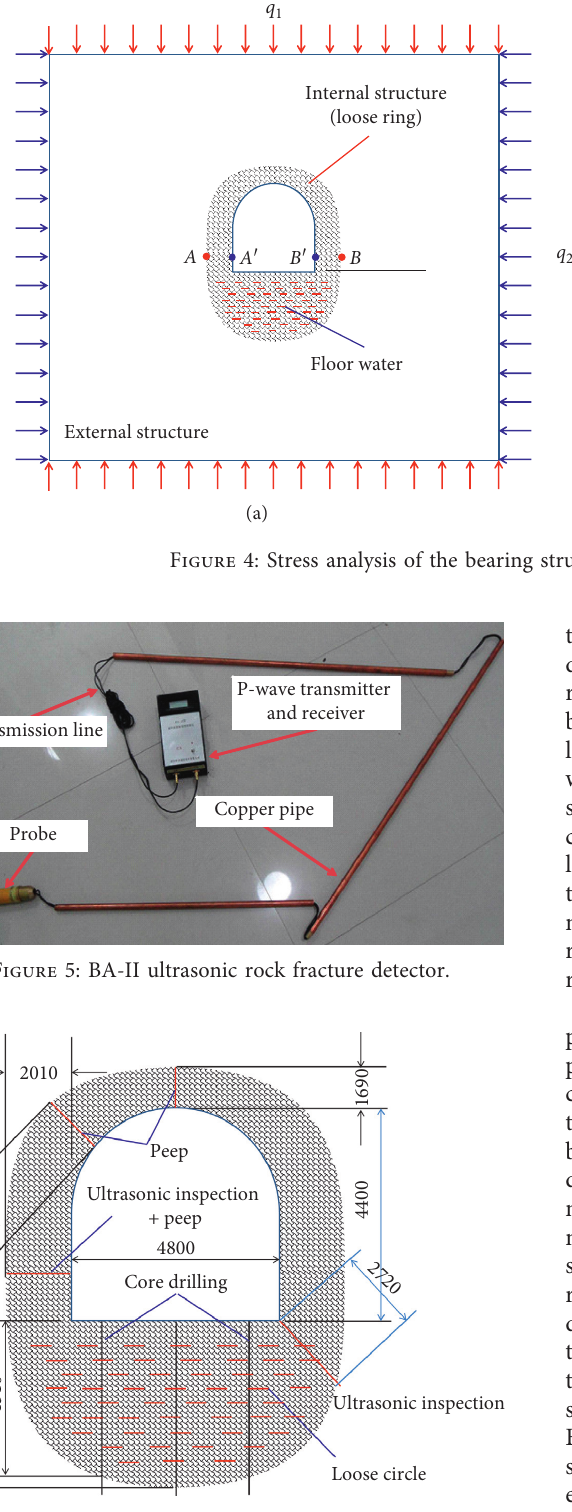
Figure 6: Detection scheme of the broken rock zone in 101 track roadway of Yuandian No.1 coal mine (unit: